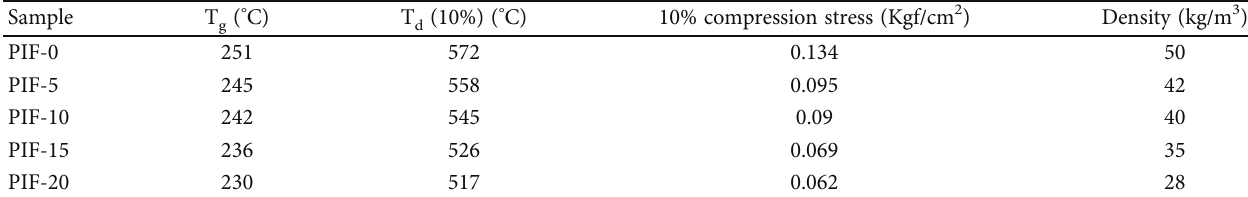
Figure 8: TGA curves of PIFs with various HMDA contents. Table 2: Physical properties of PIFs with various HMDA